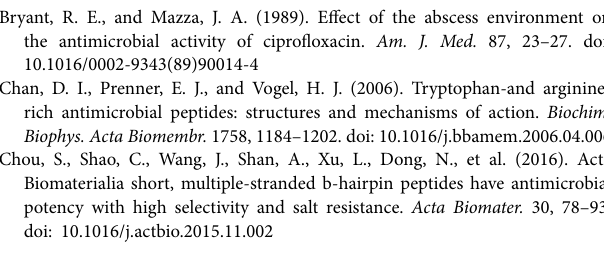
FIGURE 4 | (A) Illustration of experimental protocol. (B) The therapeutic effect of peptides on bacterial abscess. The colony counting of abscess tissue (B1) and the area of lesion after treatment at 3 d. The saline group is the infected mice treated with equivalent saline and the control group refers to the uninfected mice. (C) The histological examination of abscess site by HE staining. The black arrows indicate the condition of the epidermis. The epidermis of the saline treatment was infiltrated with inflammatory cells, whereas the epidermis of VW5 treatment and ciprofloxacin treatment maintained integrity. Large-area necrosis tissue overlayed the epidermis (red arrow) of saline treatment at the abscess site. The cell debris and large amount of inflammatory cell infiltration could be observed in the dermis layer (green arrow). (D) The inflammatory cytokines level after the treatment of saline, VW5, and ciprofloxacin. (E) The skin toxicity of VW5. The TUNEL assay was performed to detect the apoptotic cells (green) in mice skin, and the nuclei of the cells were counterstained with DAPI (blue). DMSO (dimethyl sulfoxide) injection serves as a positive